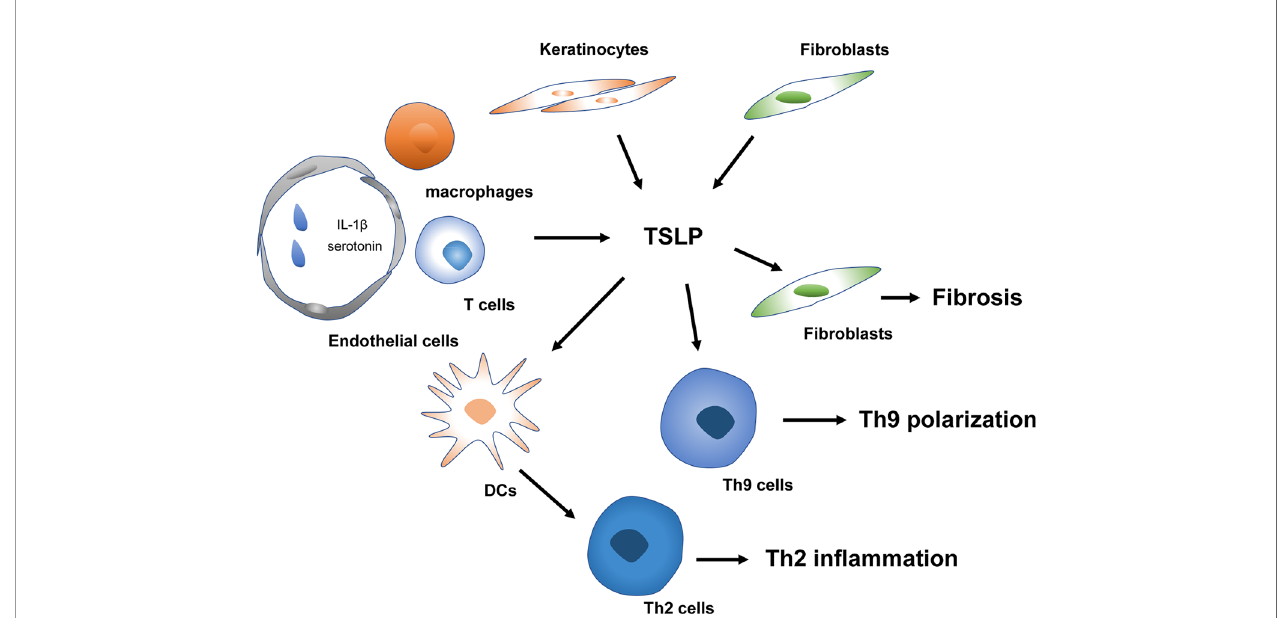
FIGURE 3 | TSLP in the pathogenesis of SSc. TSLP mediates early Th2 and Th9 in fl ammation and late fi brosis of SSc. Platelets derived IL-1 b and serotonin trigger TSLP released by vascular endothelial cells. TSLP contributes to Th2 and Th9 polarization in the early stage of SSc. Keratinocytes and fi broblasts releasing TSLP can modulate the fi brosis process in combination with TGF- b in the late phase of SSc. SSc, systemic sclerosis; IL, interleukin; Th2 cells, type 2 T helper cells; Th9 cells, type 9 T helper cells; DCs, Dendritic cells; TGF- b , transforming growth factor- b